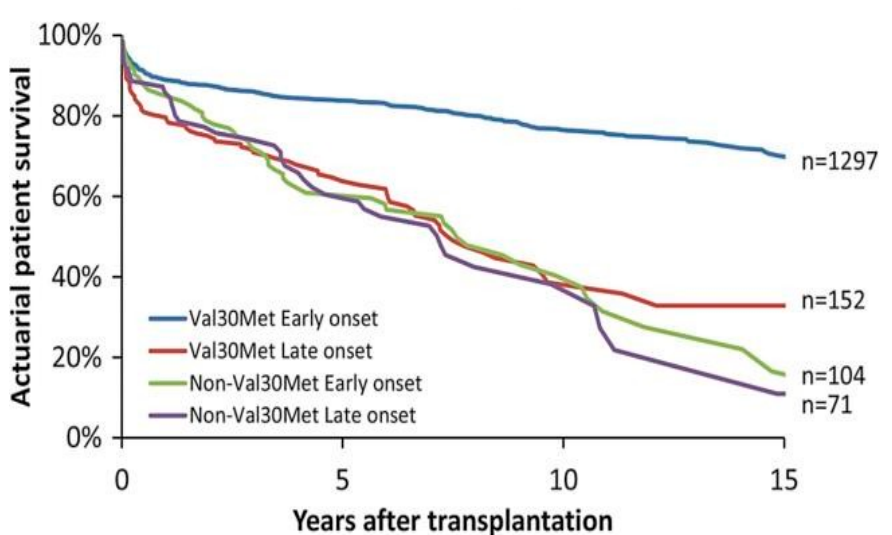
Figure 3. Patient survival between 1990 and 2010. Comparison between TTR Val30Met/non-TTR Val30Met mutations and early or late onset of disease.